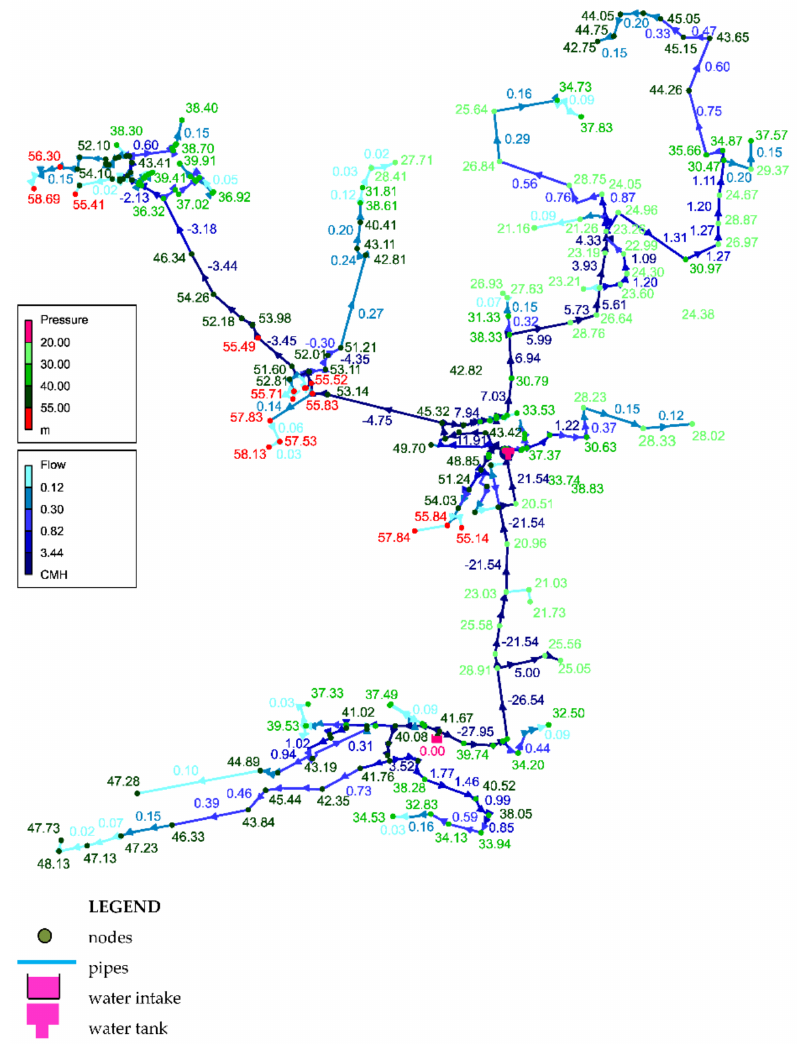
Figure 4. The pressure and flow rate in the network for average hourly water demand (the entire network)—all customers have guaranteed water